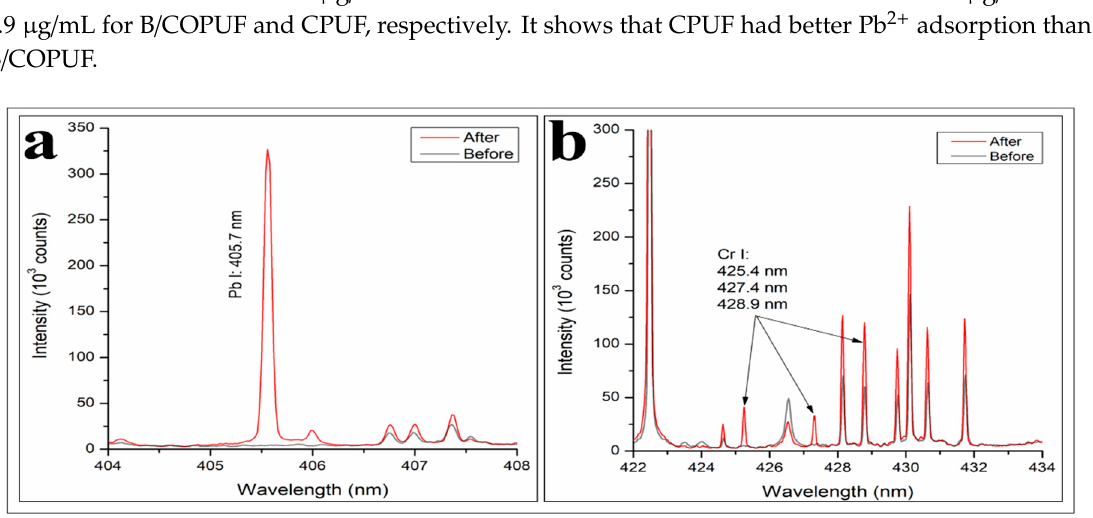
Figure 11. LIBS spectra of commercial PUF after and before the adsorption of ( a ) Pb 2+ and ( b ) Cr (VI), analyzed at 83 mJ energy and 3 Torr air pressure.